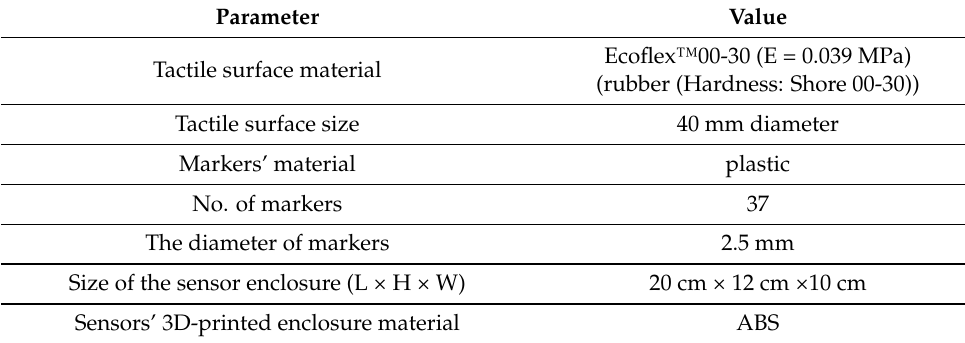
Figure 4. The fabrication process of the elastic tactile surface. ( a ) CAD model of the tactile core mould. ( b ) The 3D printed core mould. ( c ) The core mould with the cured material. ( d ) The final sensor after sticking the markers to the internal pockets. Table 2. Design features of the tactile sensor elastic material and internal